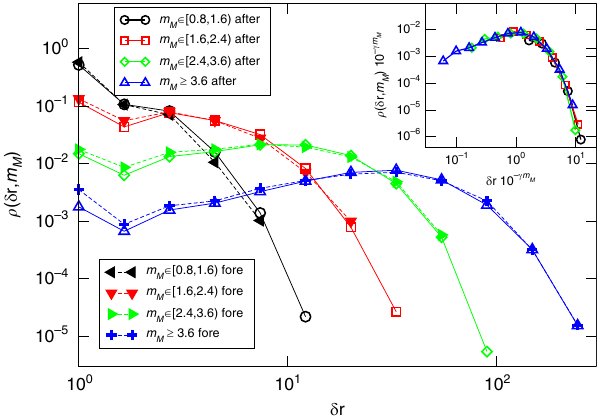
Fig. 7 The spatial clustering of aftershocks and foreshocks. The spatial density of aftershocks ρ aft ( δ r , m M ) (open symbols) and foreshocks ρ ð δ r ; m Þ ( fi lled symbols) as function of the hypocentral distance from M fore the mainshock epicenter δ r . Different colors correspond to different mainshock magnitude classes m M . In the inset we show the same data after rescaling by the size of the aftershock area L ð m M Þ ¼ 10 γ m M and γ = 0.54. We always consider Θ = 0.5, σ = 5, L = 1000, and ϵ = each layer, the correct long-range interaction expected from elasto- static theory 2 being replaced (see Eq. (1)) with the short-range term k h ∇ 2 h i . Indeed under this short-range approximation, after- shocks can be triggered only within or at the boundary of the rupture zone, as was shown in refs. 35,36 . Finally, we note that this spatial clustering law can be related to the m – logA scaling of Fig. 4, with γ = 1/(2 γ 0 ). Indeed since aftershocks are mostly distributed on the border of the area fractured by the mainshock, one has